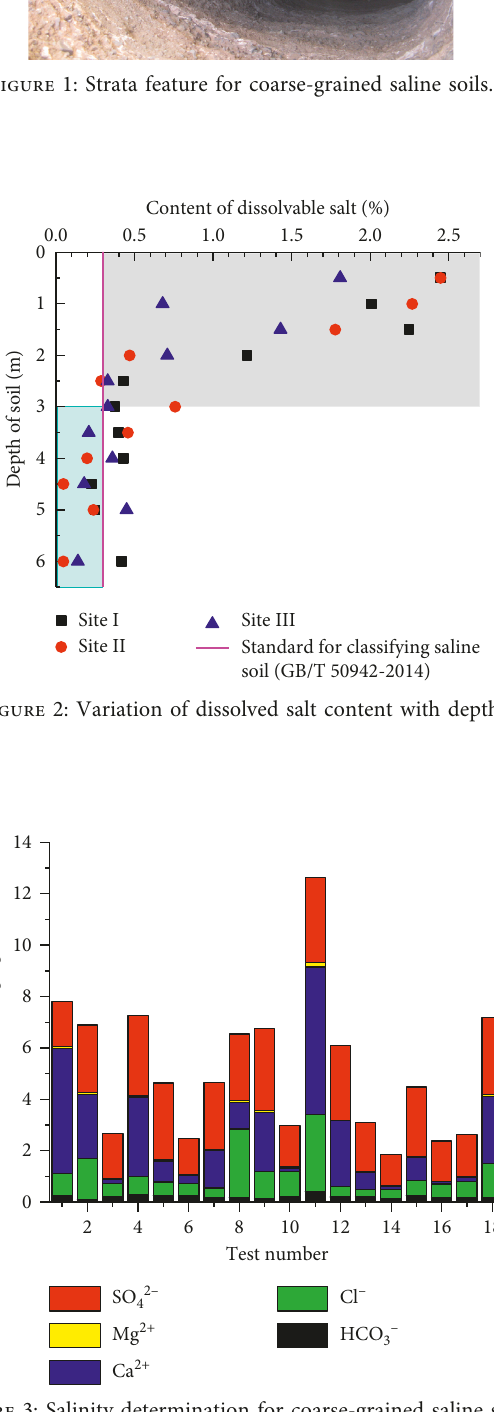
Figure 3: Salinity determination for coarse-grained saline